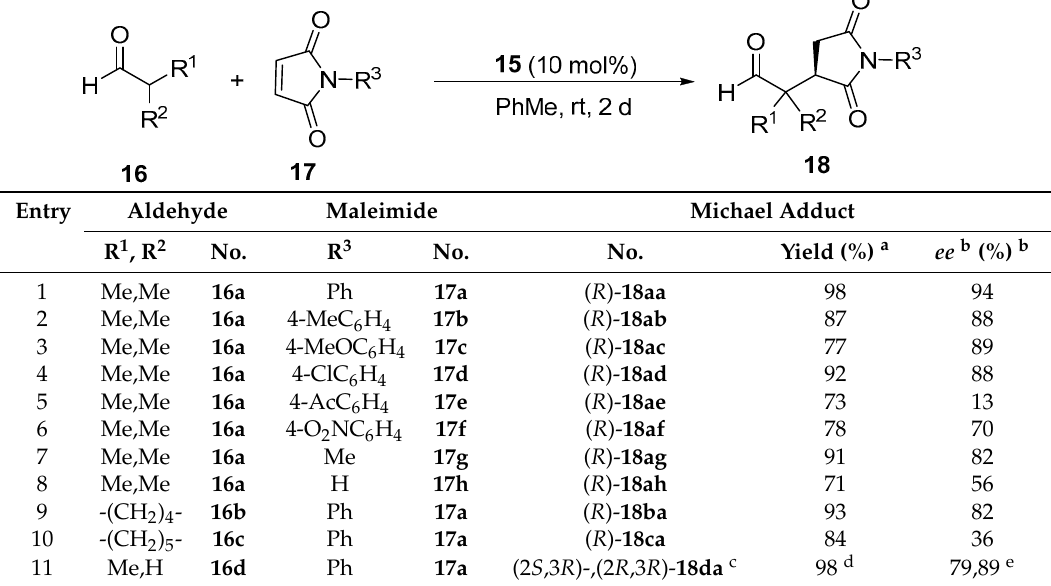
Molecules 2018 , 23 , x FOR PEER REVIEW